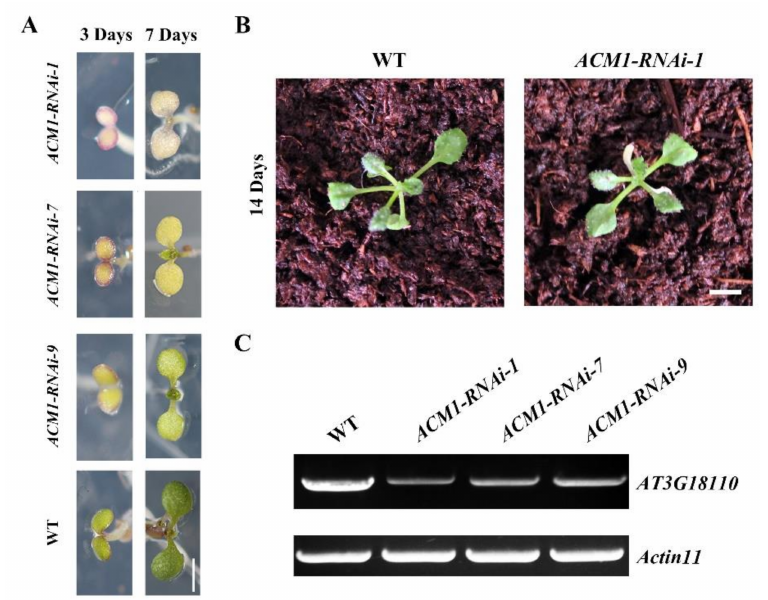
Figure 2. Characterization of the ACM1 -RNAi transgenic plants. ( A ) Identification and isolation of RNAi lines with different degrees of inhibition of ACM1 expression. Plants were grown on 1/2 MS medium with 2% (w/v) sucrose for 3 d and 7 d. Scale bar is 1 mm. ( B ) Albino cotyledon but normal true leaves phenotype of ACM1 -RNAi-1. Plants were grown on soil (14 d). Scale bar: 2 mm. ( C ) Reverse transcription PCR analysis. Using specific primers for AT3G18110 and Actin 11 for 29 cycles for WT and RNAi lines with different degrees of inhibition of ACM1